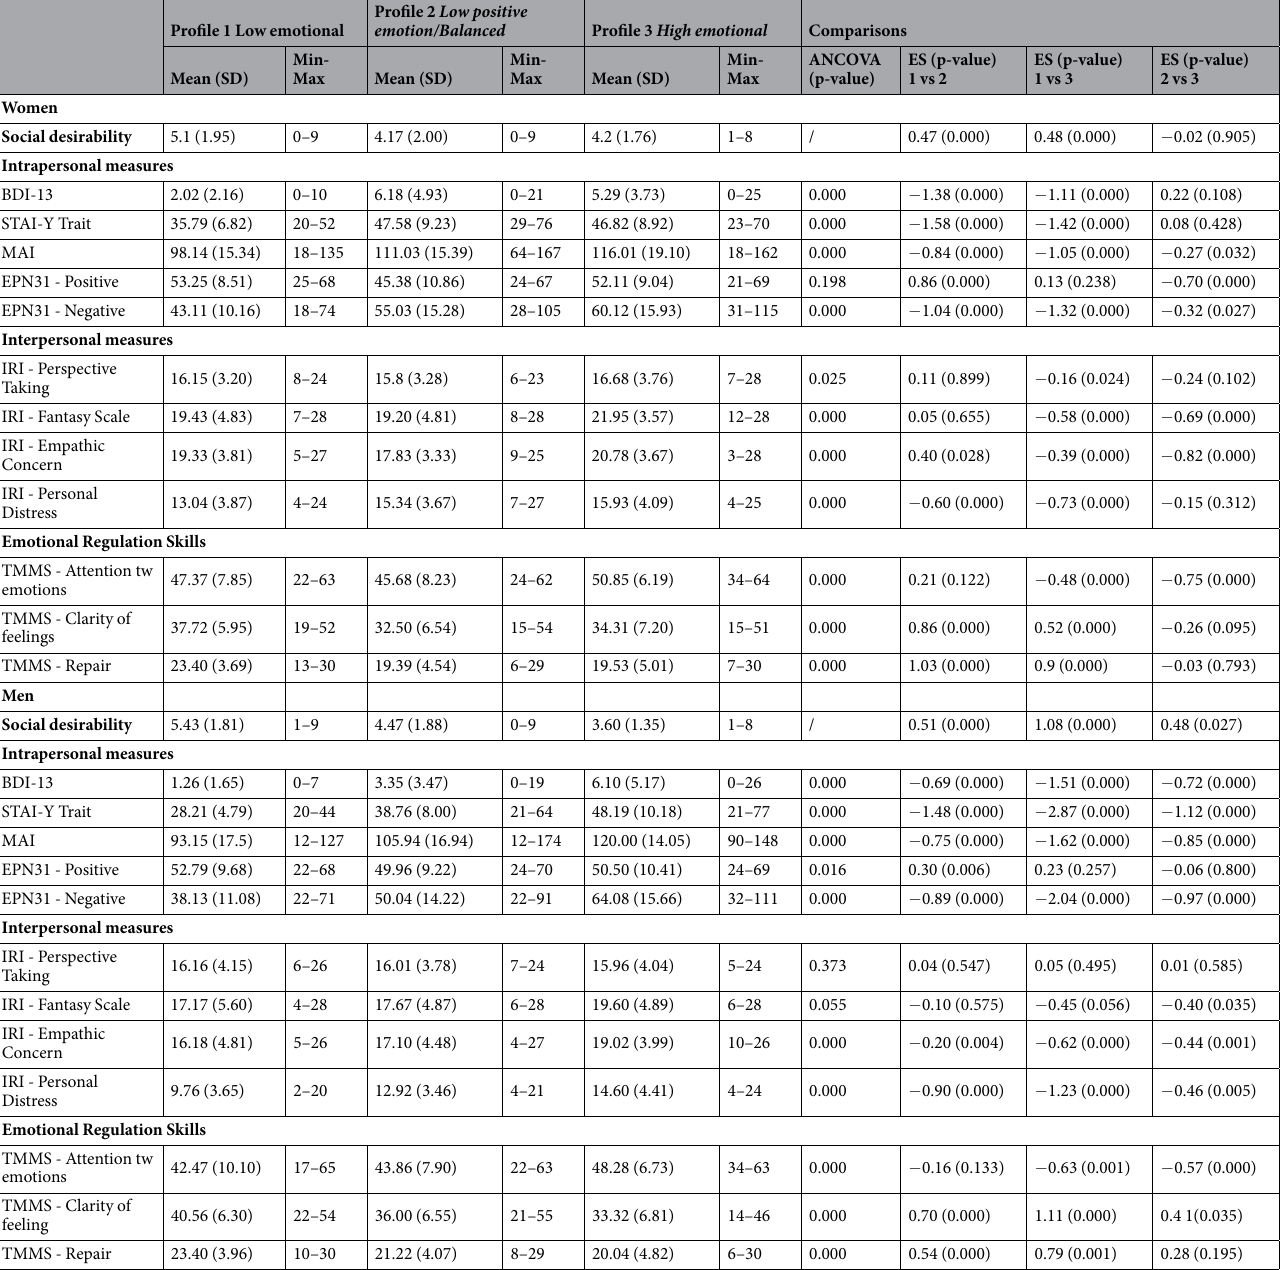
Table 4. ANPS profiles in relation to intrapersonal, interpersonal and emotion regulation variables in Sample 2. SD = Standard Deviation; ES = Effect Size (based on Hedge’s g); BDI-13 = Beck Depression Inventory short version; STAI-Y = Spielberger State-Trait Anxiety Inventory-Y; IRI = Interpersonal Reactivity Index; MAI = Multidimensional Anger Inventory; EPN31 = Positive and Negative Emotionality Questionnaire; TMMS = Trait Meta-Mood Scale. All p-values based on F statistic adjusted for Social Desirability. P-values for the comparisons across profiles should be interpreted as statistically significant if < 0.017 due to Bonferroni